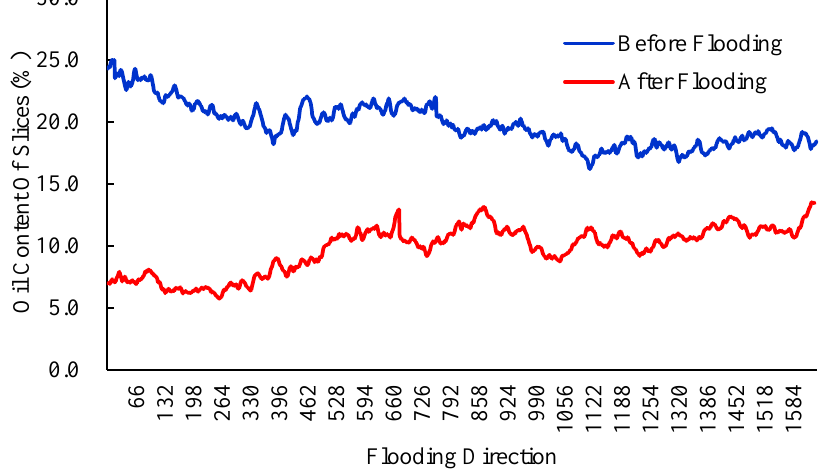
Figure 4. Dynamic change of oil content at different slices along the Z-upward direction.